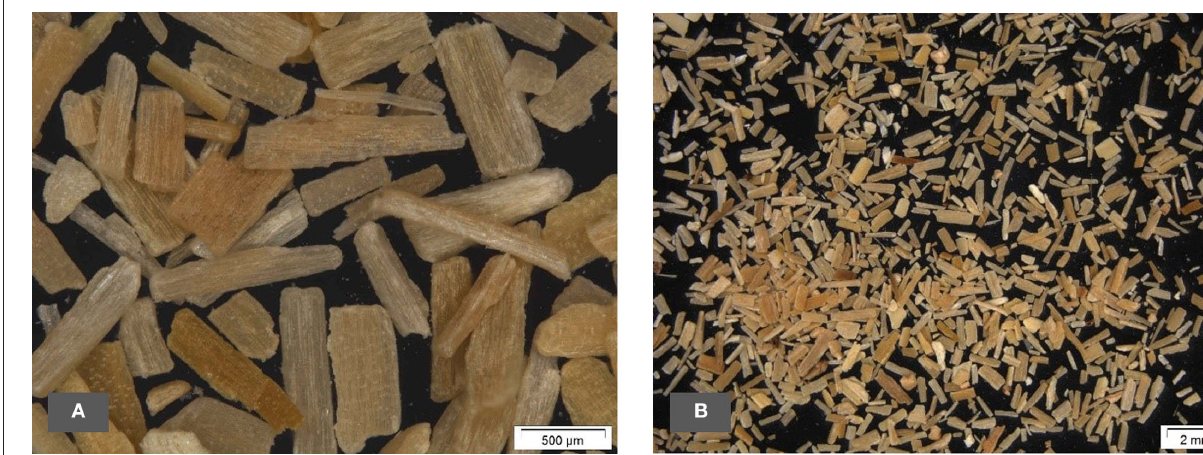
FIGURE 7 | (A,B) Light microscope pictures of oat husks.